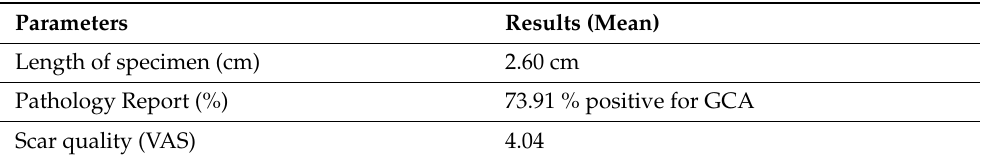
Table 1. Postoperative Results.